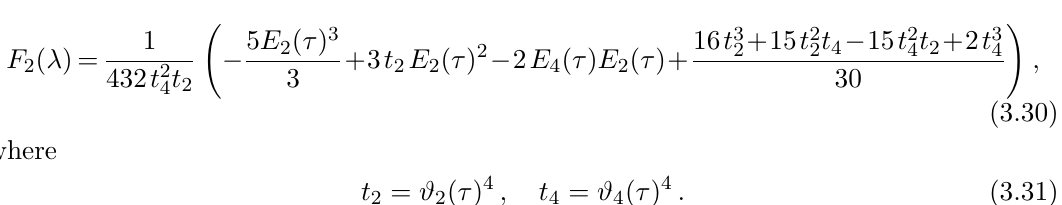
Figure 1 . The genus-1 free energies (3.27) (blue circles) and (3.33) (yellow triangles) for different values of the ’t Hooft coupling: 1 (right). < λ ≤ 30 (left) and 1 < λ ≤ 1 24 24 3 The non-perturbative genus-2 free energy can also be given explicitly in terms of Eisenstein series and Jacobi theta functions upon solving the holomorphic anomaly equation (see again [4] for a